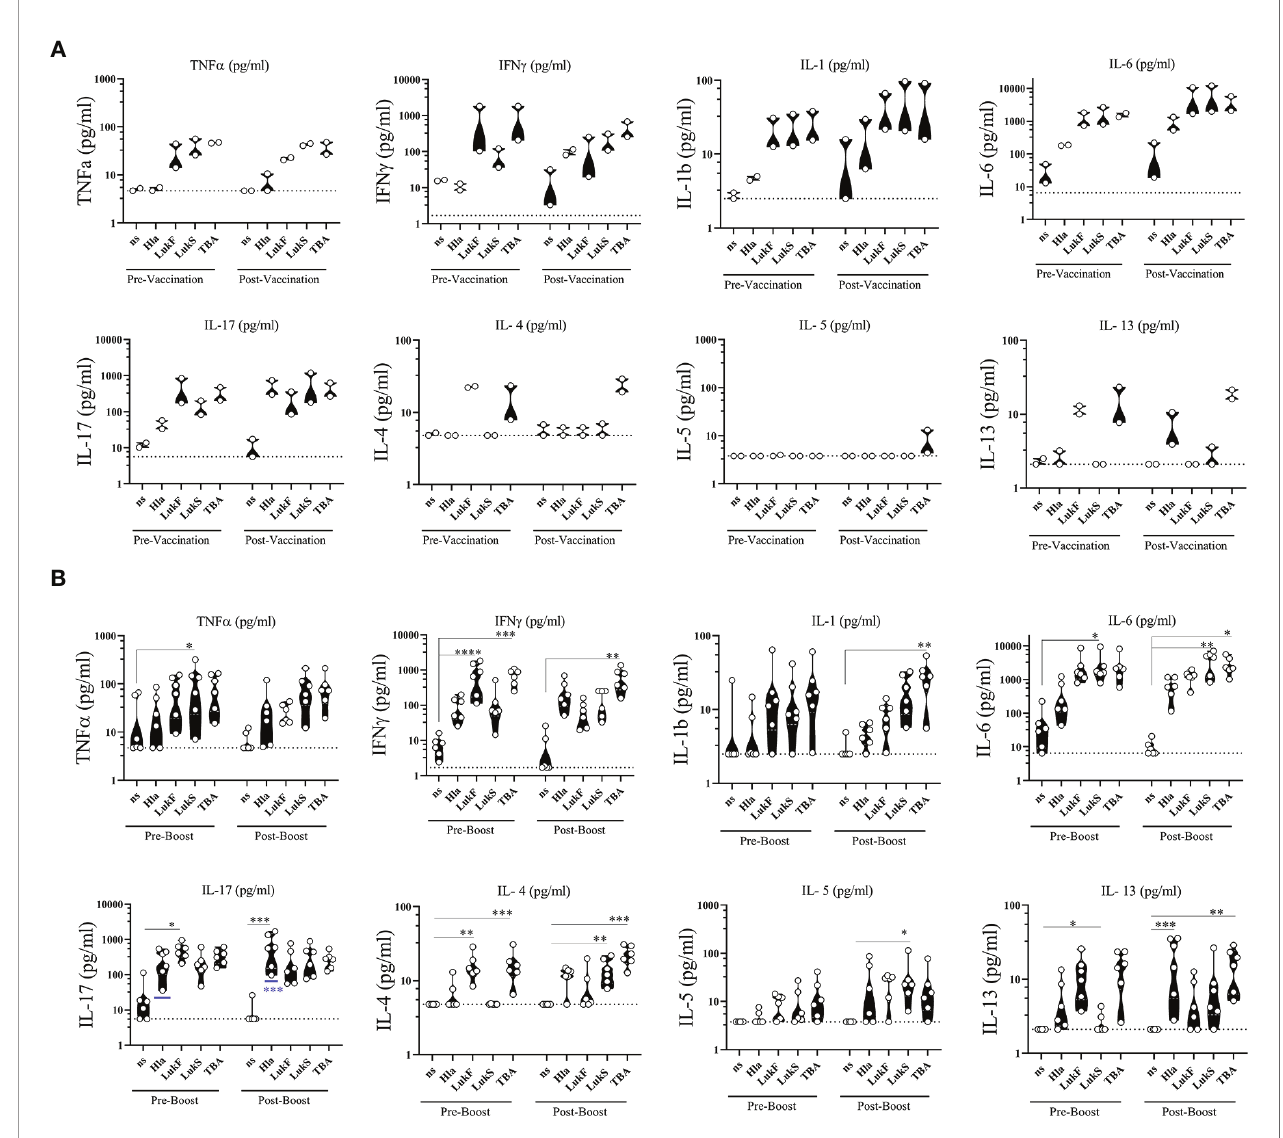
FIGURE 8 | Ex vivo cytokine release. Cytokines released from PBMCs of non-human primates (NHPs) in response to stimulation with individual vaccine components Hla H35LH48L (Hla), LukF mut1 (LukF), LukS mut9 (LukS), and TBA 225 (TBA). (A) PBMCs were collected prior to (Pre-Vaccination) and 14 days after 1 st vaccination (Post- Vaccination). (B) PBMCs were collected prior to (Pre-Boost) and 14 days after 3 rd booster vaccination (Post-Boost). Controls were left non-stimulated (ns). Shown are violin plots with individual data points. Limit of detection is shown as dashed grey lines. *<0.05; **<0.01; ***<0.001; ****<0.0001. Data was analyzed with GraphPad PRISM